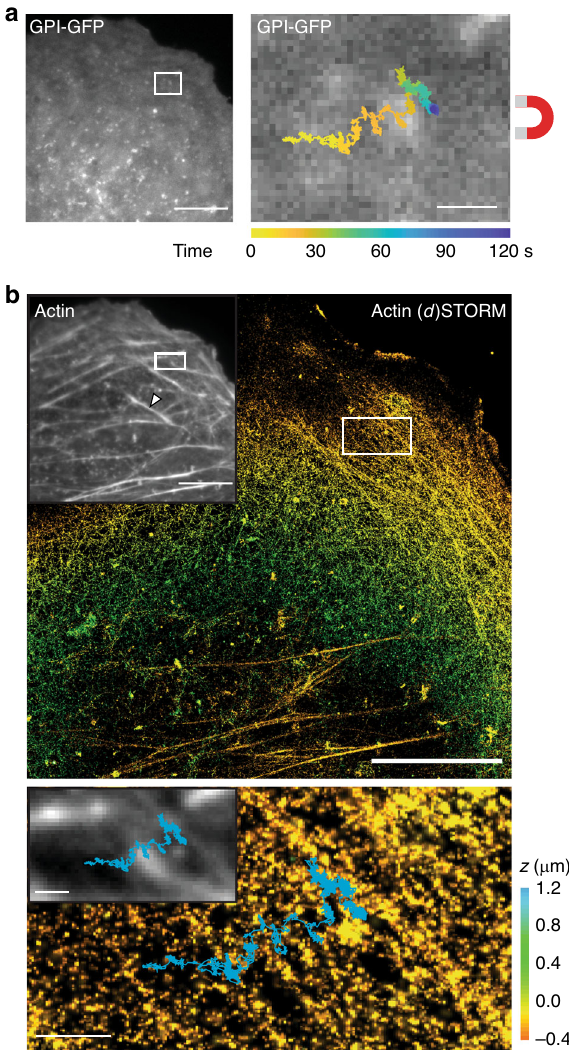
Fig. 4 Correlation of FMNP-steered protein movement and the underlining F-actin cytoskeleton. a Live fl uorescence image of the membranous GPI-GFP signal in a CV-1 cell. Scale bar is 10 μ m. Right: Trajectory of a FMNP bound to GPI-GFP and pulled by the magnetic needle overlaid onto the GPI-GFP signal. Scale bar is 1 μ m. b Top: Phalloidin-AF647 stained F-actin in the same cell as in a after fi xation, imaged by conventional epi fl uorescence microscopy (inset) and 3D ( d )STORM super- resolution microscopy (color scale by depth z , bottom 0.6 μ m z -slice not included). Arrowhead in the epi fl uorescence inset indicates a stress fi ber, which is excluded in the super-resolution z -slice. Scale bar is 10 μ m. Bottom: Trajectory of FMNP (cyan) overlaid onto the epi fl uorescence (inset) and ( d )STORM image after image registration via fi ducials. Scale bar is 1 μ